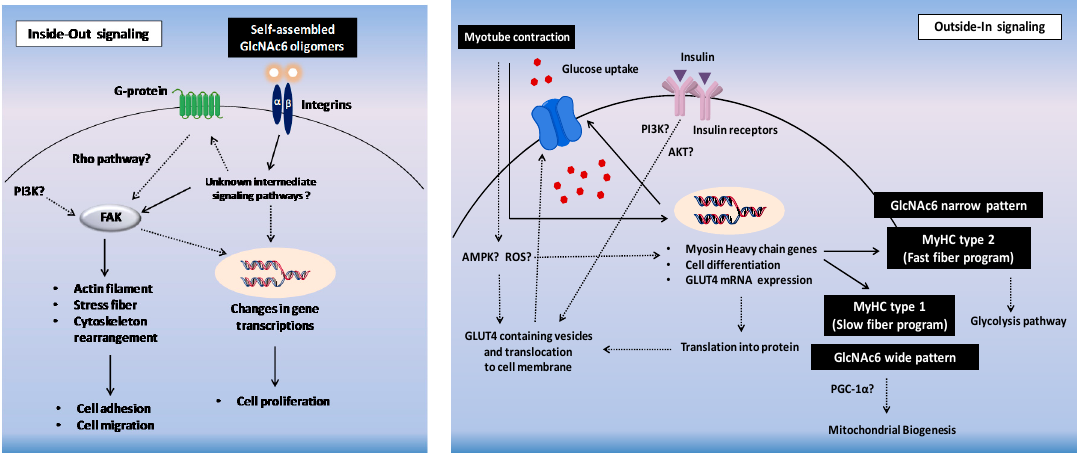
Figure 1. Schematic illustration of differentiation behavior and myoblast fusion on microscale topographical patterns of hexa- N -acetyl- D -glucosamine (GlcNAc6)-self-assembled monolayers (SAMs) and GlcNAc6-free substrates, directing myotube formation and the possible cellular signaling machinery involved in gene regulation and contraction-stimulated glucose uptake through a specific GlcNAc6–receptor interaction on cell surfaces, which denoted in a dashed black box. The main signaling pathways for possible regulation through GlcNAc6 oligomers interacting with glyco-receptor proteins in myoblasts (thick arrows) and the convergence of unknown signaling pathways that induce myoblast fusion (dashed arrows) are depicted. Scale bars represent 200 µm.